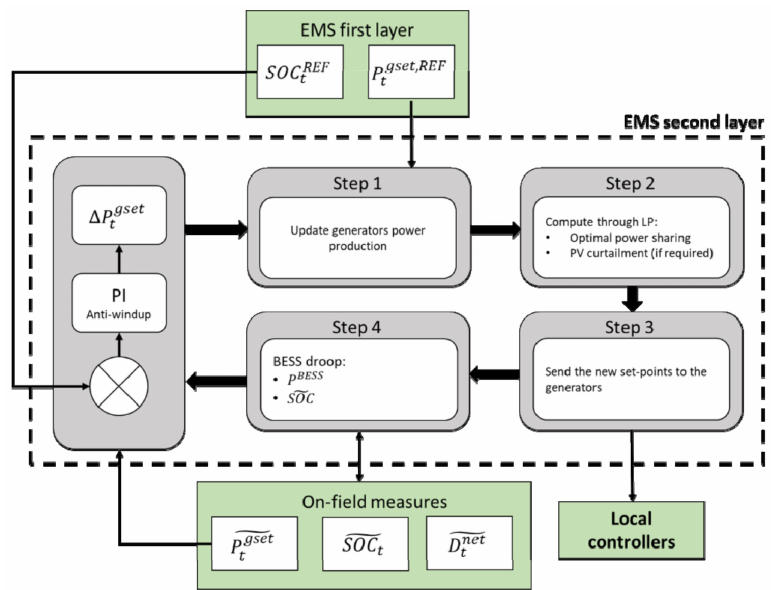
Figure 3. Second layer